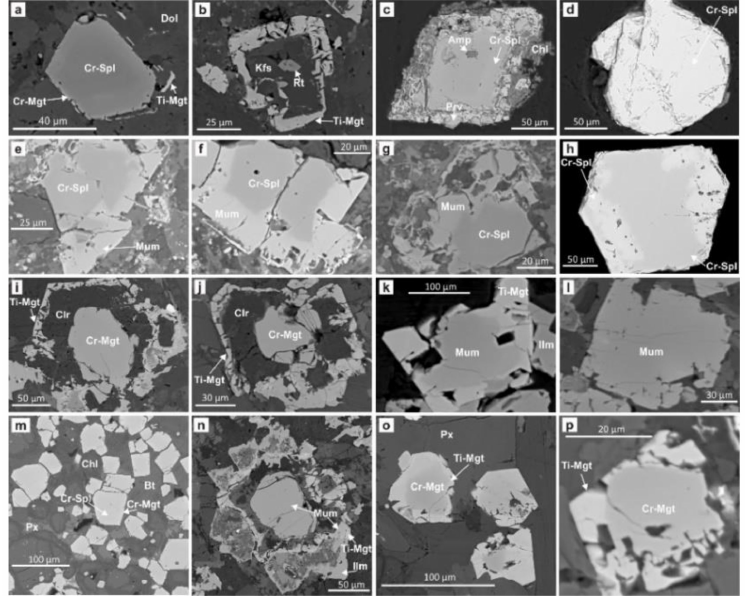
Figure 2. BSE images of minerals of the spinel group from Terina aillikites ( i – p ); Chuktukon damtjer- nites ( a – d , h ) and aillikites ( e – g ). Cr-Spl—chrome spinel, Cr-Mgt—Cr-magnetite,